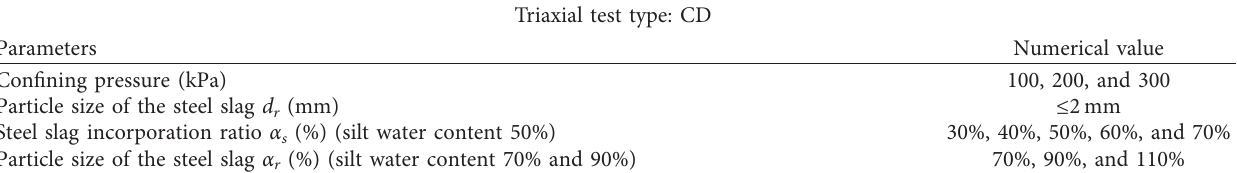
Table 2: Static triaxial test conditions of the sample.